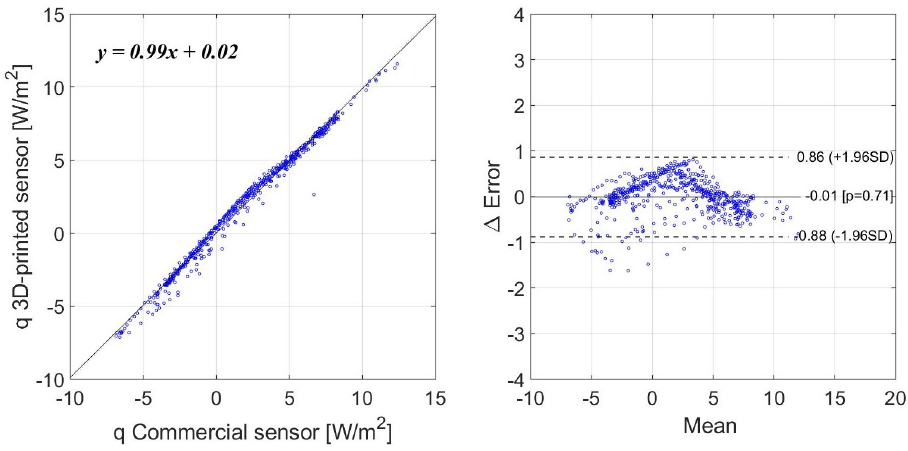
Figure 14. Bland–Altman analysis for long-term measurements and a narrow